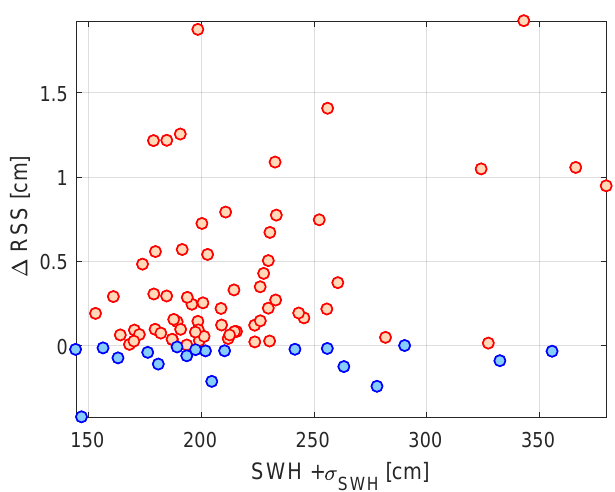
Figure 10. ∆ RSS absolute values for the closest node to the tide gauge against the sea state, represented as the averaged SWH computed at each node plus its standard